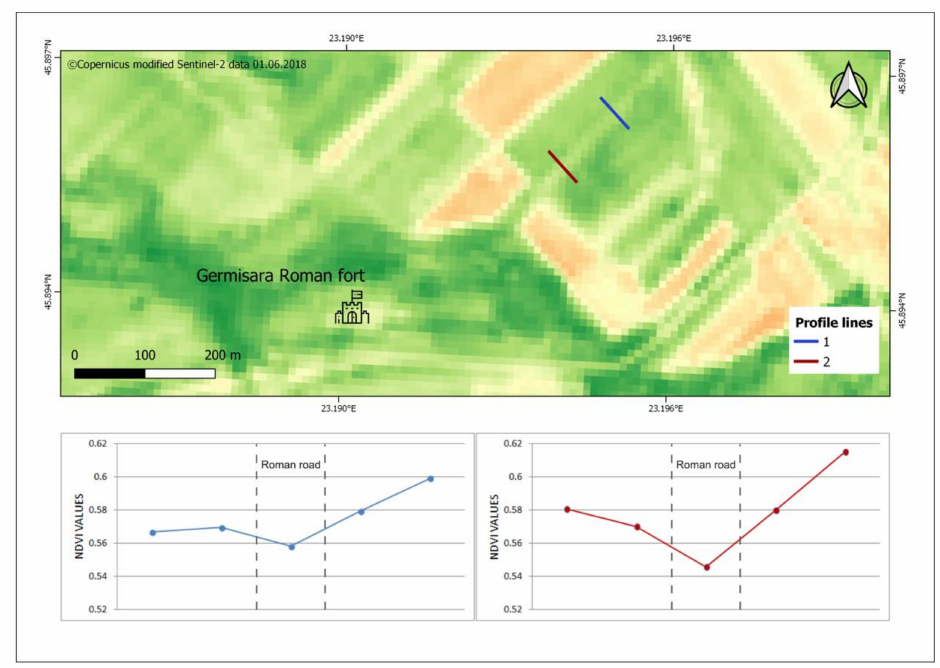
Figure 15. Cross–sections on NDVI image output derived from Sentinel–2 imagery. The graphs below the image represent the NDVI values of the pixels crossed by the two